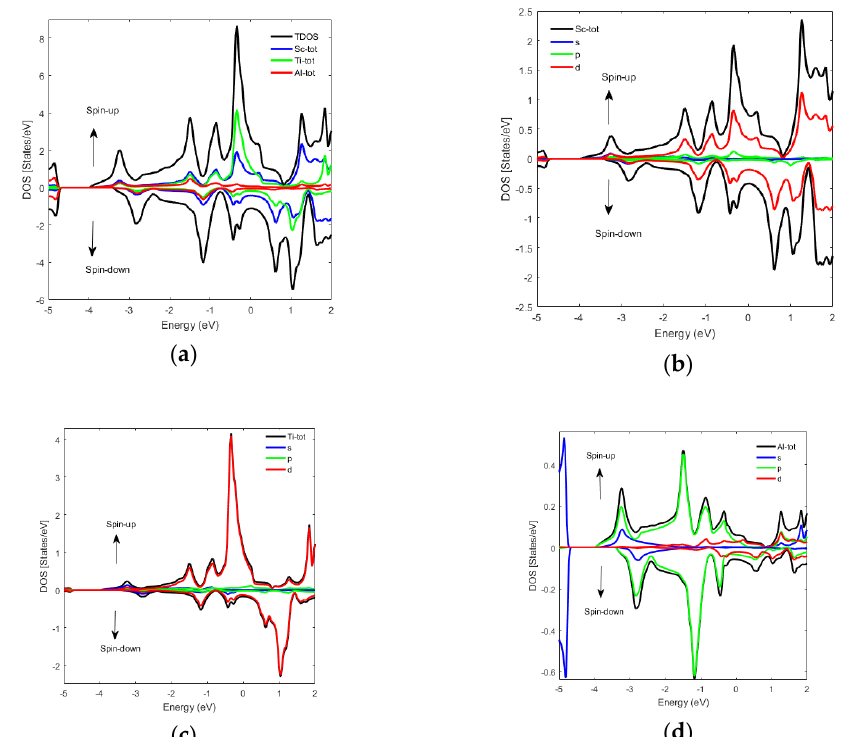
Figure 5. ( a ) TDOS for regular Sc 2 TiAl, and PDOS for the ( b ) Sc atom, ( c ) Ti atom, and the ( d ) Al atom. In the spin-up and spin-down states of regular Sc 2 TiSi (Figure 6), the Sc-d and Ti-d states, as well as the s- and p-states of Si, make the main contributions to the valence and conduction bands.